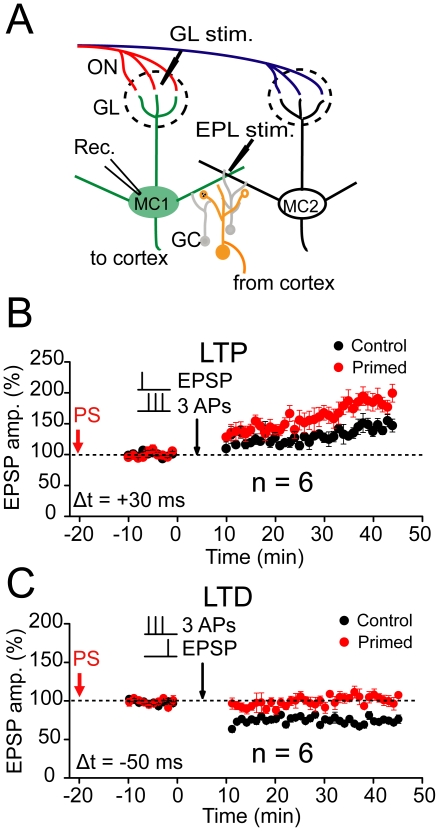
Regulation of STDP by prior TBS of distal inputs at the EPL.(A) Schematic of experimental configuration. Whole-cell recording was conducted in a MC. Bipolar stimulation electrodes were placed at the correlated glomerulus (upper dotted line circle) and the EPL to activate presynaptic excitatory sensory inputs to MCs and distal inputs to GCs, respectively. (B) Prior TBS (PS) of distal inputs at the EPL facilitated LTP by increasing the magnitude of potentiation. Potentiation of EPSPs in MCs was induced with a +30 ms pairing protocol (n = 6; p<0.001). The stable EPSP baseline recording was performed 10 min after the end of the previous TBS. (C) PS of distal inputs at the EPL suppressed LTD by decreasing the magnitude of depression (n = 6 ; p<0.001). The control data in B and C are the same as in Fig. 3C and G, respectively.